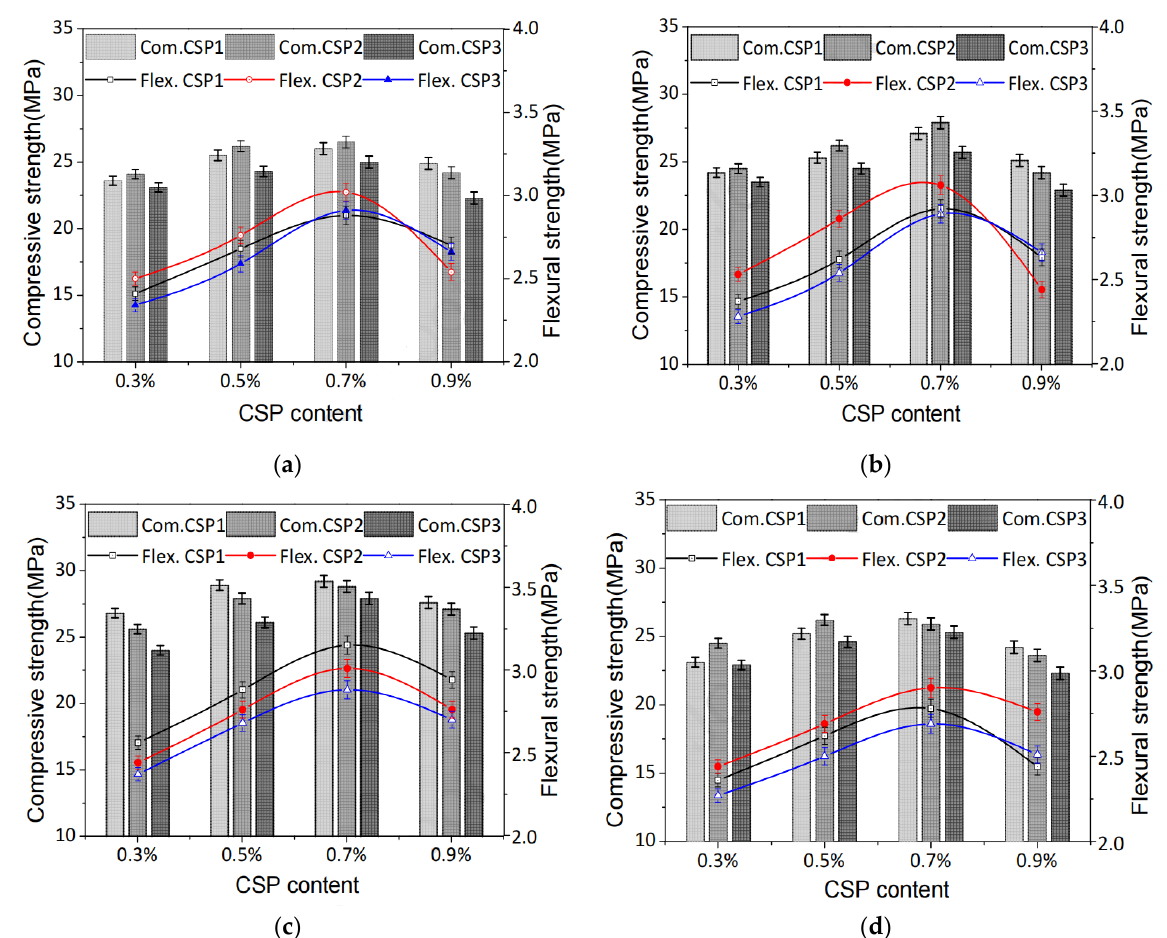
Figure 14. Compression and bending properties of PFRGs with different cotton stalk powder (CSP) content and particle size for 28 days. ( a ) Fiber untreated, ( b ) alkali treated, ( c ) PVA liquid treated and oil treated ( d ) [95].